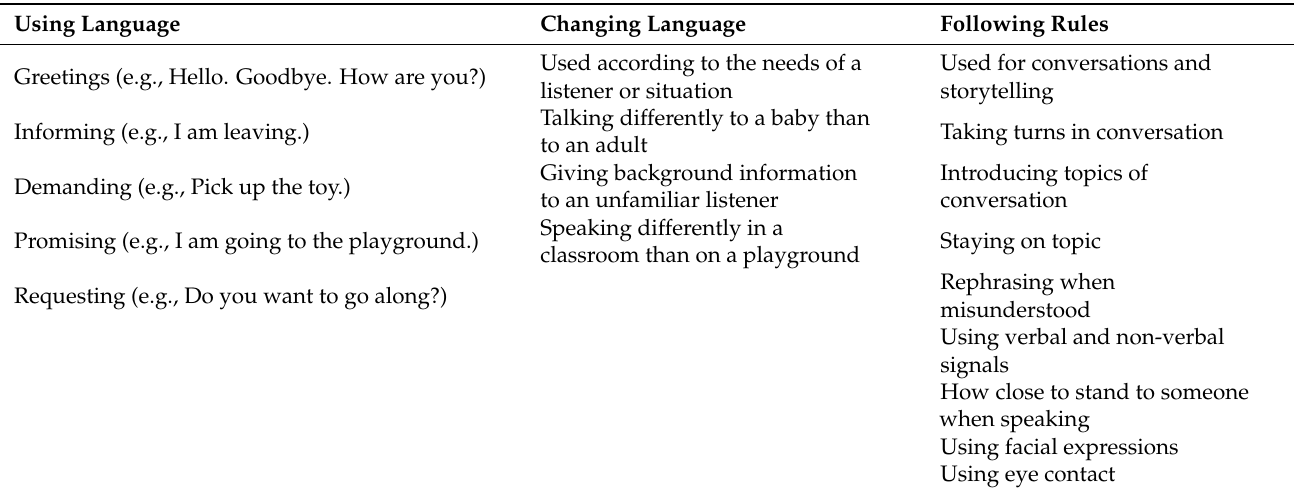
Table 1. Major communication skills of pragmatic competence (adapted from ASHA, as cited in [63] (p. 12)).